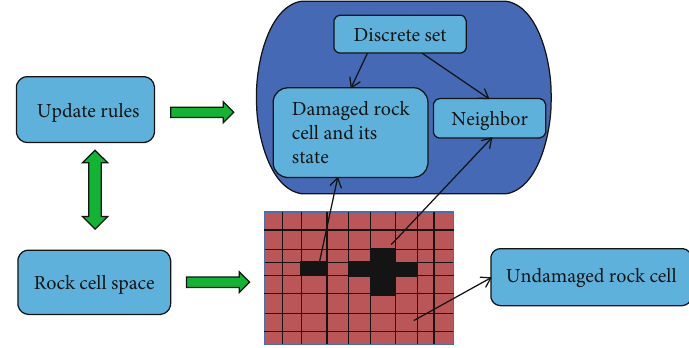
Figure 4: Diagram of the relationship between elements of rock cell